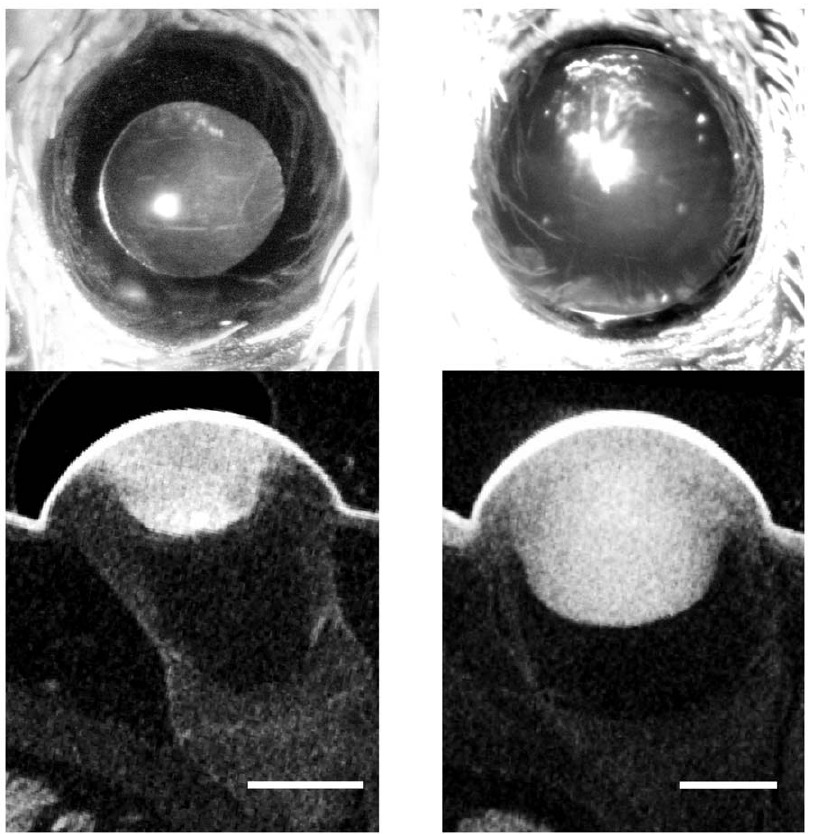
Figure 3. Comparison of micrographs and microCT scans. The upper part shows in vivo micrographs of a PM eye of a spider the day after ecdysis (left panel) and 9 days after ecdysis (right panel), taken just before the preparation of the spiders for the micro CT scans. The lower part shows sections through the reconstructed PM eyes. Scale bars: 200 m m.